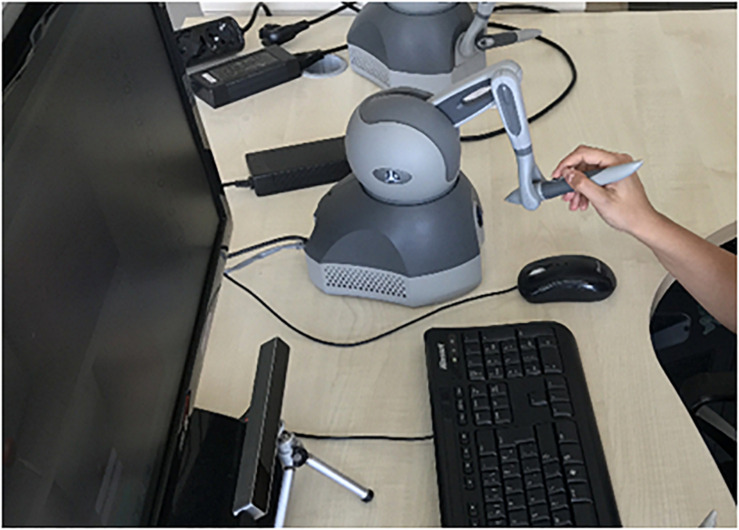
Experiment design.